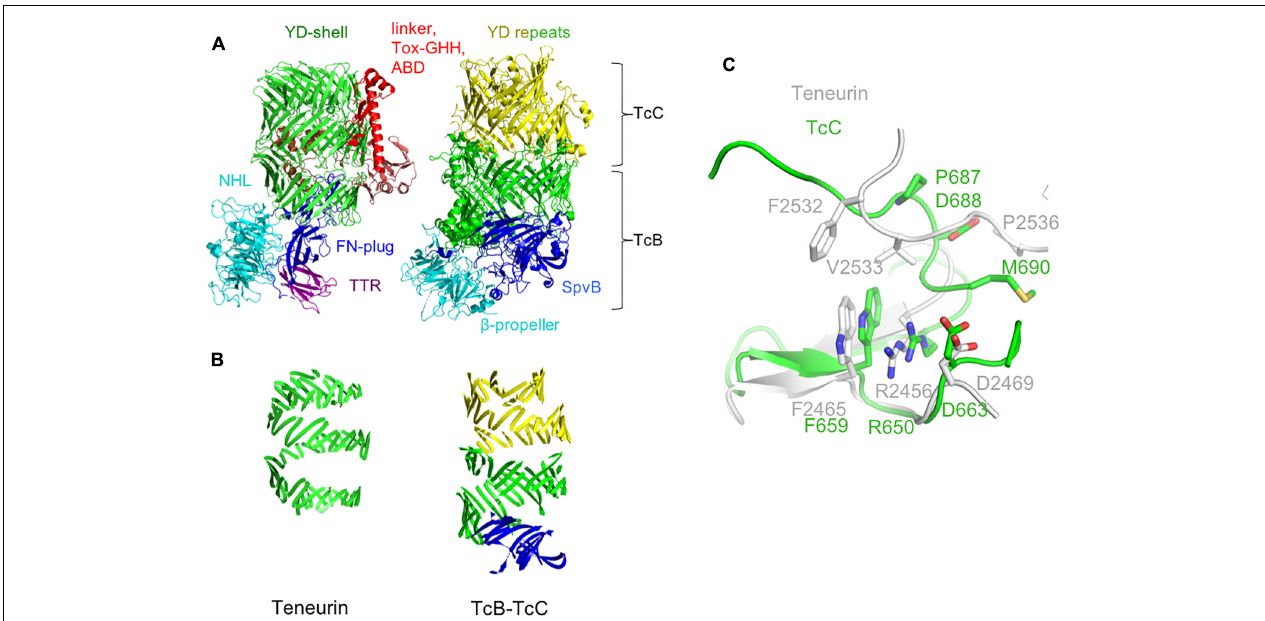
FIGURE 2 | Comparison of the teneurin scaffold and peripheral domains with the TcB-TcC complex. (A) Chicken Ten2 (left) is shown in the same orientation as the TcB-TcC complex (right), with structurally equivalent regions colored accordingly (green and yellow: YD repeats, cyan: NHL domain and β -propeller, dark blue: FN-plug and SpvB domain). (B) The YD-repeat regions of both proteins, illustrating the larger size of the shell in TcB-TcC. (C) Structural alignment of the teneurin (gray) and TcC (green) Rhs-associated core-like domain at the autoproteolytic cleavage site of